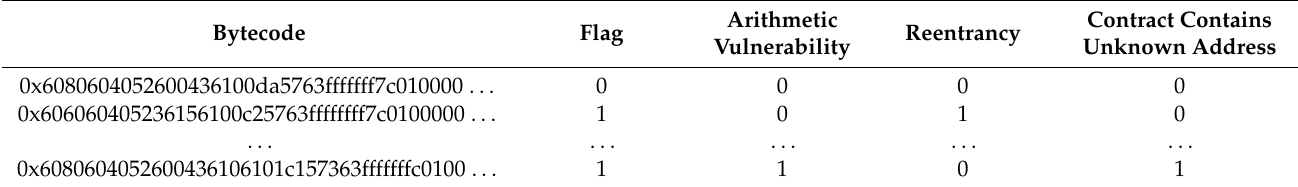
Table 2. Samples of the smart contracts datasets.